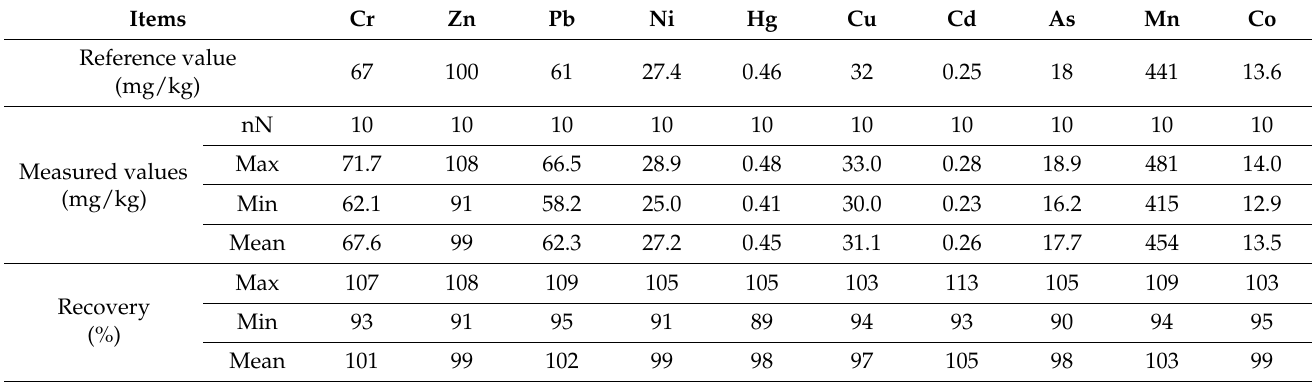
Table 1. Measured values and recovery of standard reference materials GSS-16